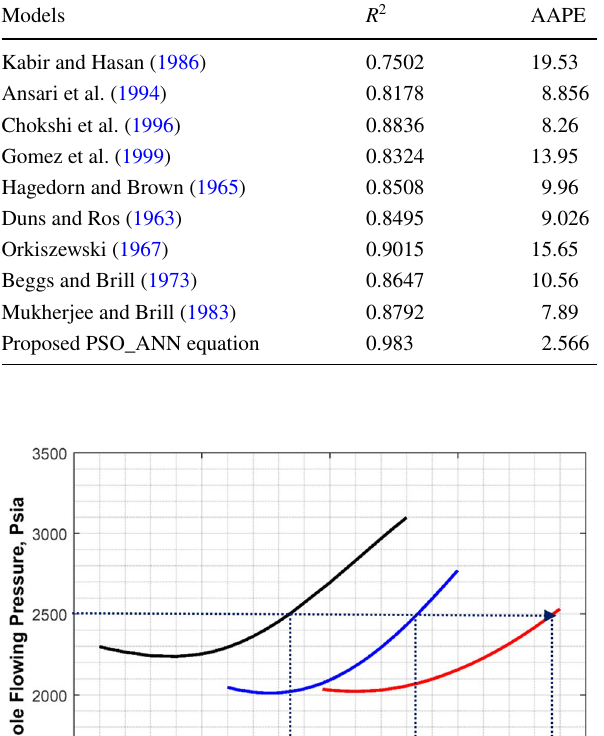
Table 7 Statistical analysis of the comparison between empirical cor- relations, mechanistic models, and proposed ANN model on testing dataset Models